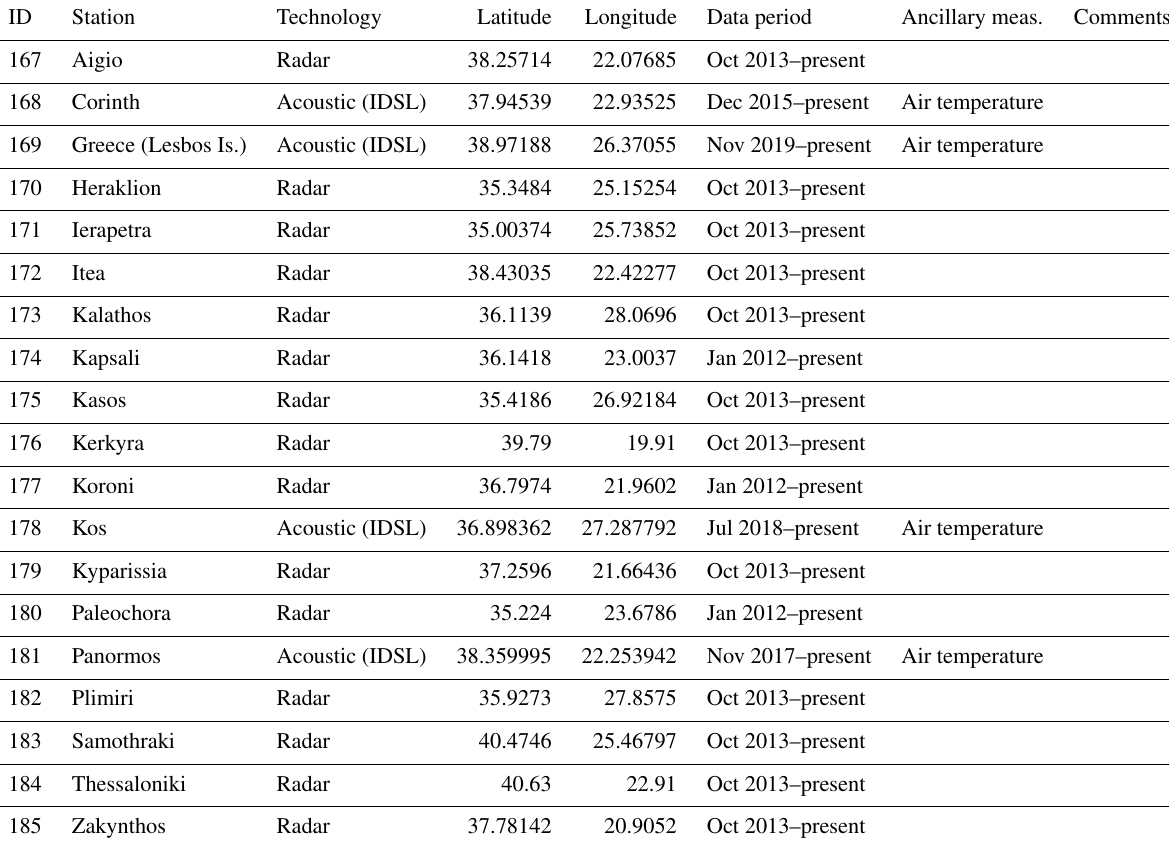
Table A17. Network of stations operated by NOA in Greece, in collaboration with the